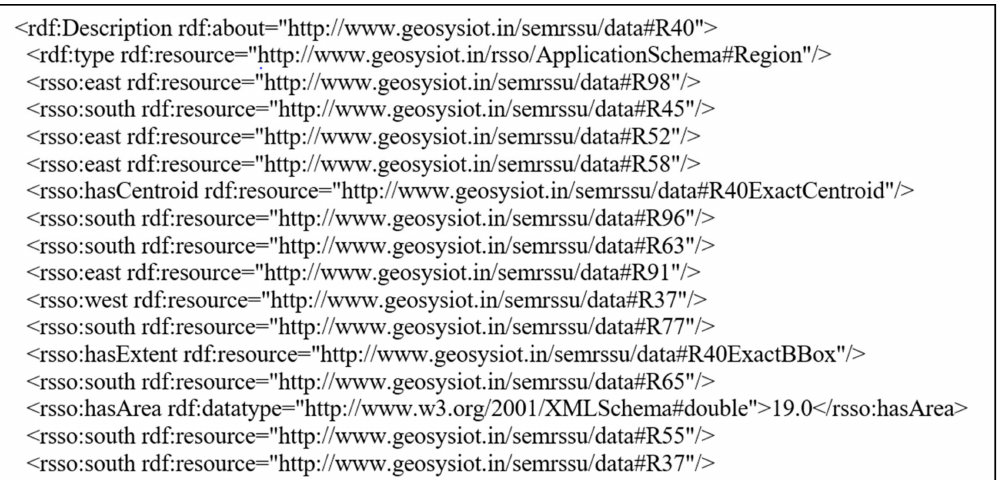
Figure 5. Snippet of the Scene Knowledge Graph represented in the Resource Description Framework (RDF) form for a region in the remote sensing